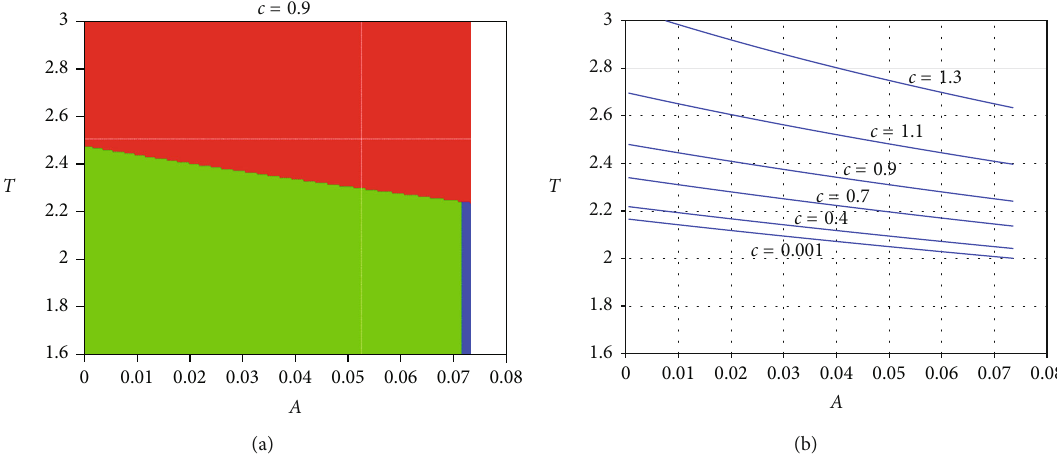
Figure 3: (a) With c = 0 : 9 . The values of A and T that satis fi ed the conditions of Theorem 7 for existence and exponentially asymptotical stability are plotted in the green area. In blue, only where the conditions of Theorem 7 for the existence are satis fi ed and in red where they are not. (b) Boundary between satisfying and not satisfying the conditions for existence of Theorem 7 for di ff erent values of c